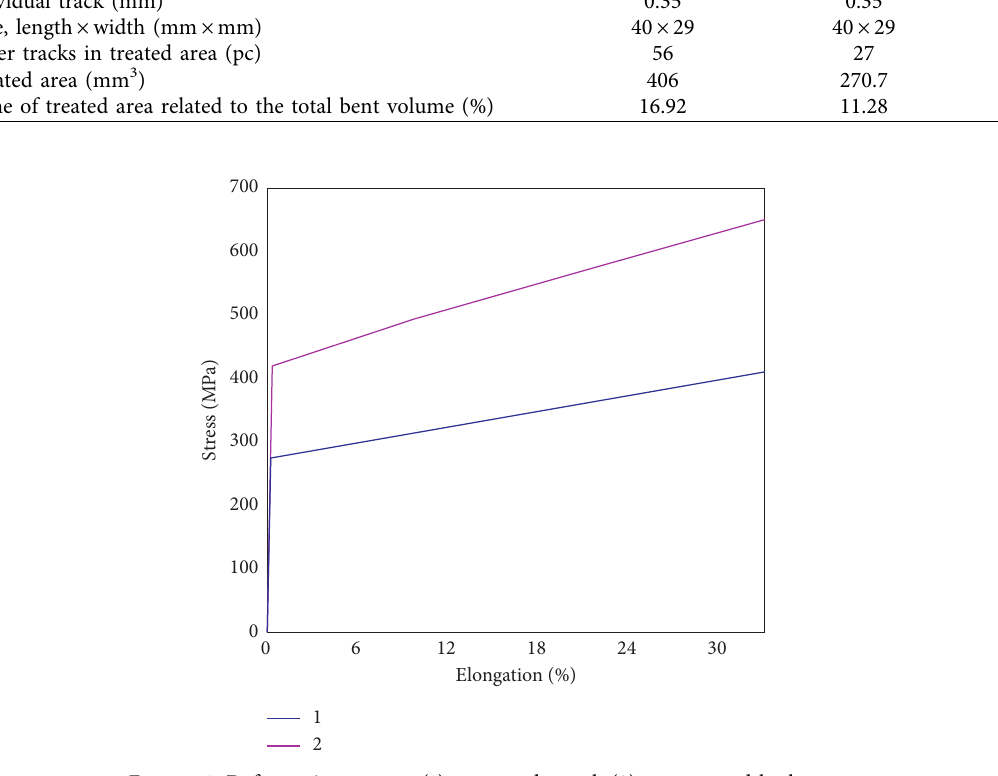
Figure 4: Deformation curves: (1) untreated metal; (2) area treated by laser. Table 7: Parameters of steel and laser-treated surfaces used to calculate elastoplastic deformation of samples.